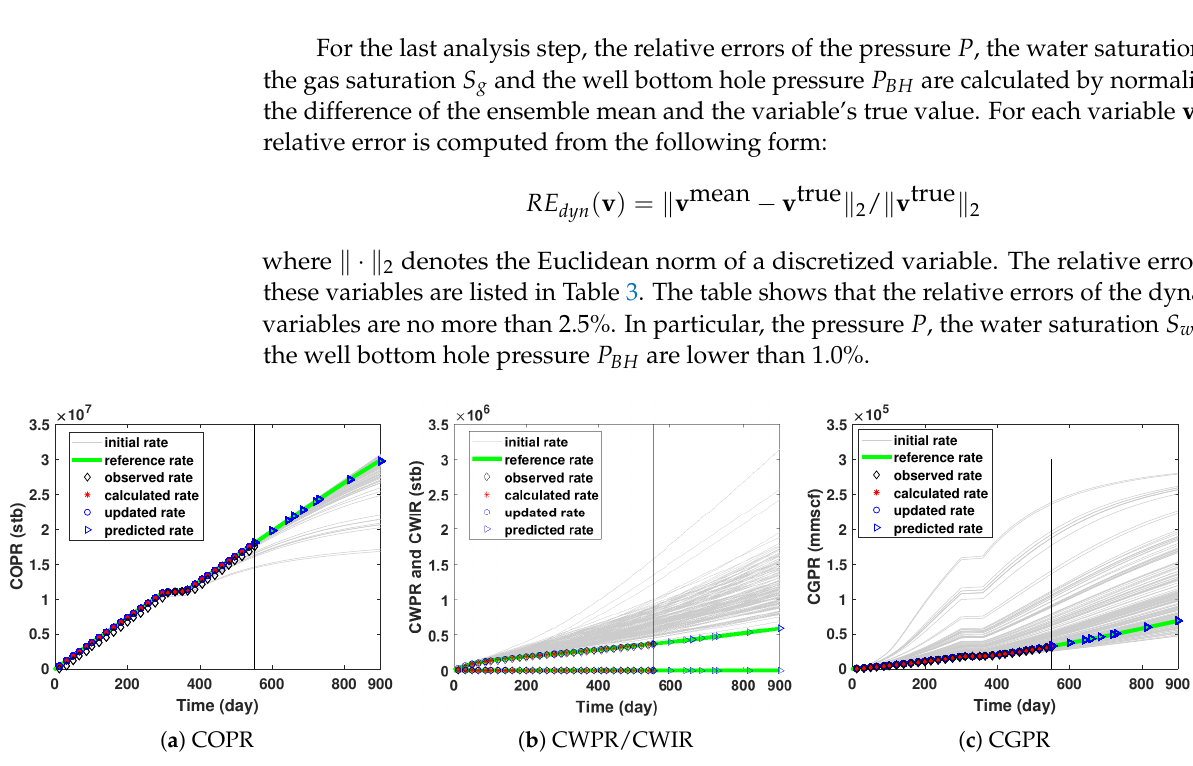
Figure 7. The production rates with known endpoints: ( a ) cumulative oil production rate; ( b ) cumulative water production rate (The upper curve is the cumulative water injection rate. The lower curve is the cumulative water production rate); ( c ) cumulative gas production rate. Table 3. The relative errors of the dynamic variables RE dyn at the last assimilation step with known